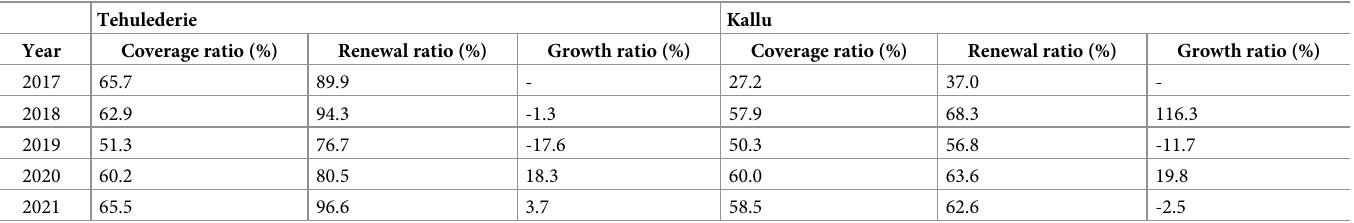
Table 1. Coverage, renewal and growth ratios of CBHI membership (2017–2021) at two case study districts of northeast Ethiopia.